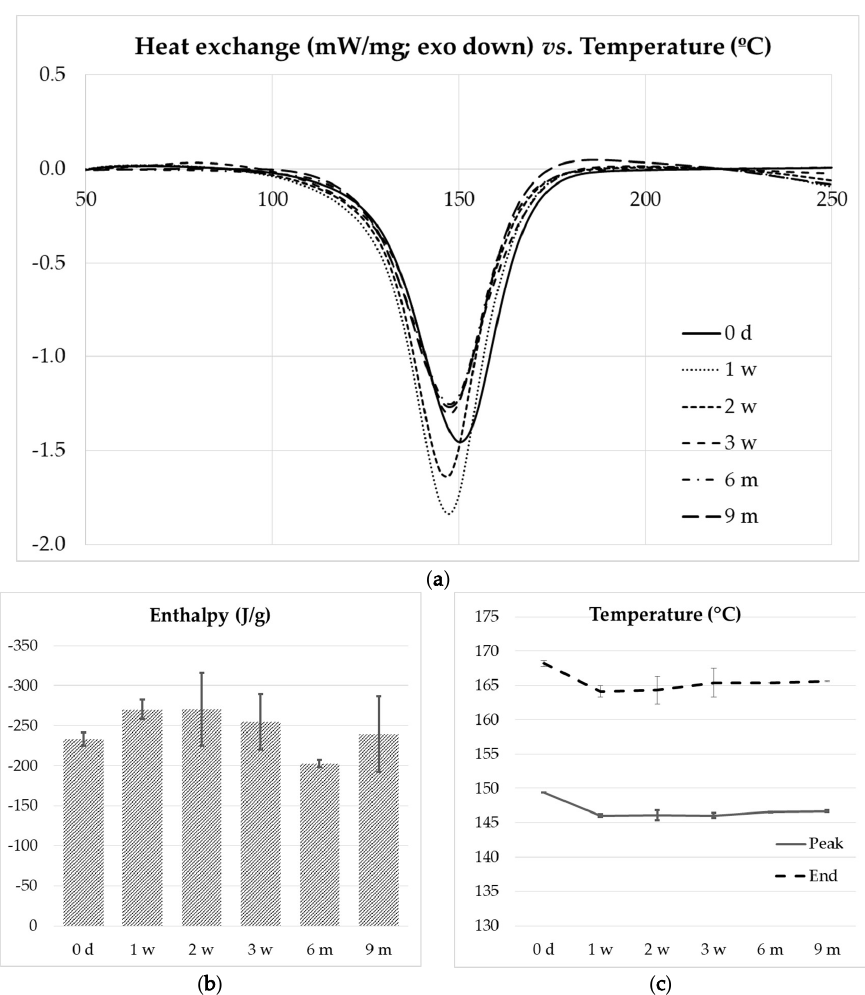
Figure 13. DSC profiles for scans at 10 °C/min of composites with 0.5 wt.% SWCNT + 2 wt.% EG after different storage times. ( a ); corresponding cure enthalpies and (b); peak temperatures and peak end temperatures ( c ).